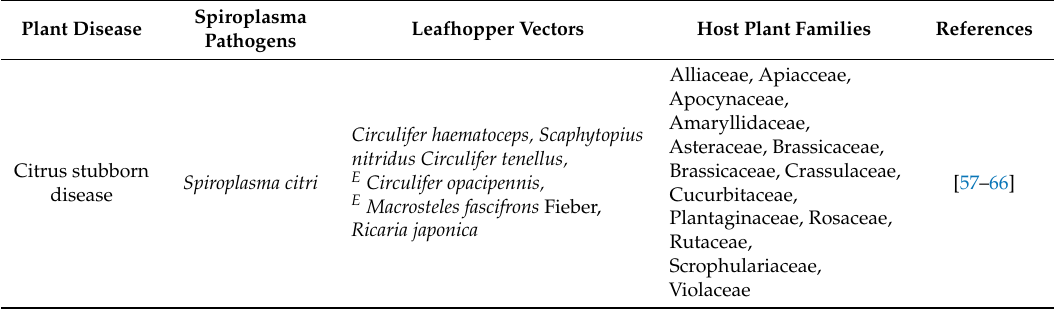
Table 1. List of plant diseases caused by Spiroplasma pathogens, their leafhopper vectors and host plant